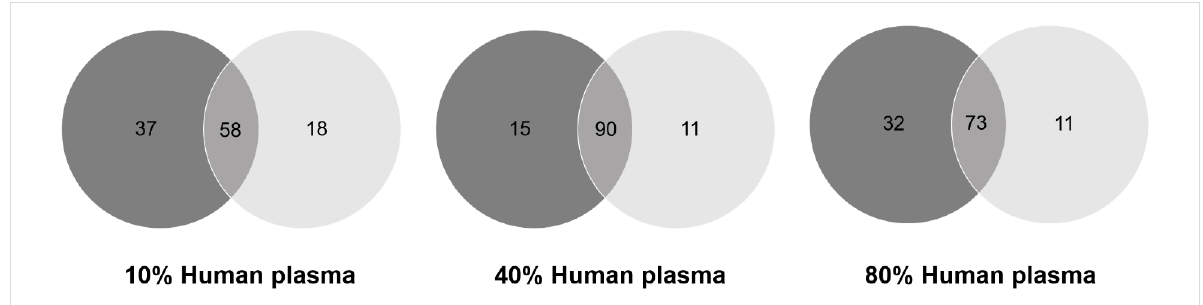
Figure 5: Venn diagrams showing the number of proteins shared by small silica (black) and carbon nanoparticle (grey) protein corona formed at dif- ferent plasma concentrations.